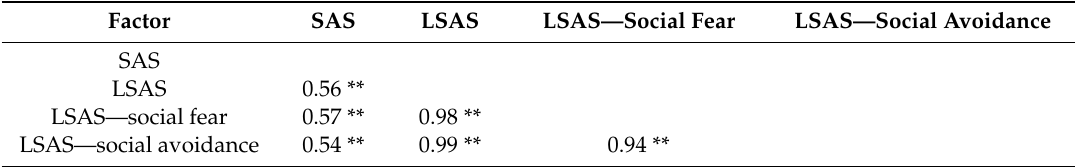
Table 2. Study 1—Pearson r correlations between questionnaires and Smartphone Addiction Scale scores ( n =